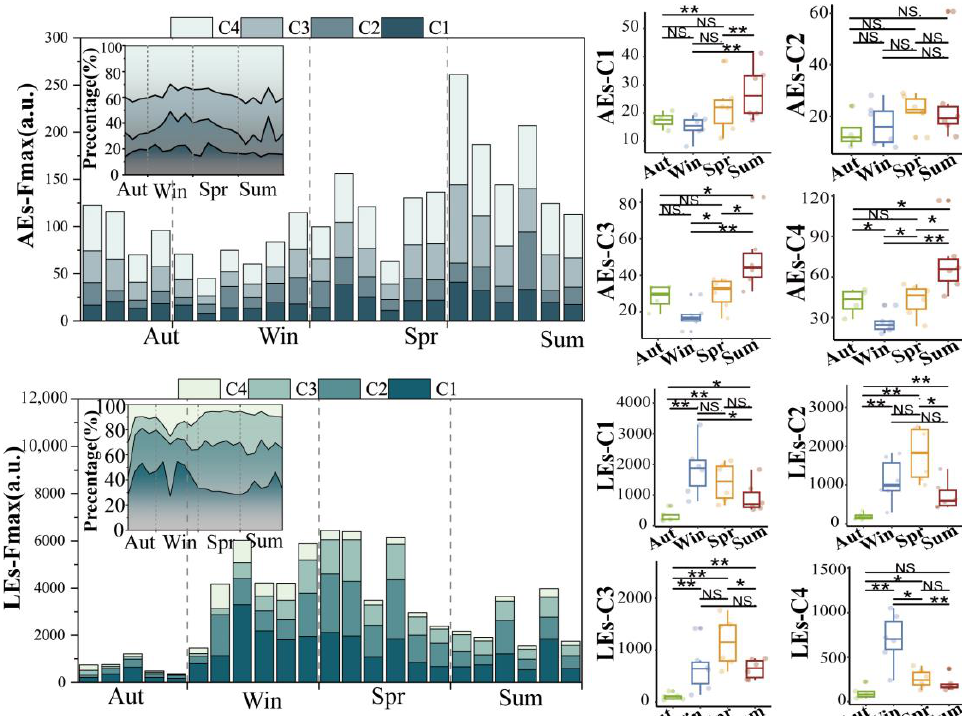
Figure 4. Seasonal variation in fluorescence component Fmax and seasonal difference U-test for AEs and LEs; * represents p < 0.05, ** represents p < 0.01. NS. stands for no seasonal variation (the figure shows the Fmax of LEs as a result of a 1000-fold dilution.).